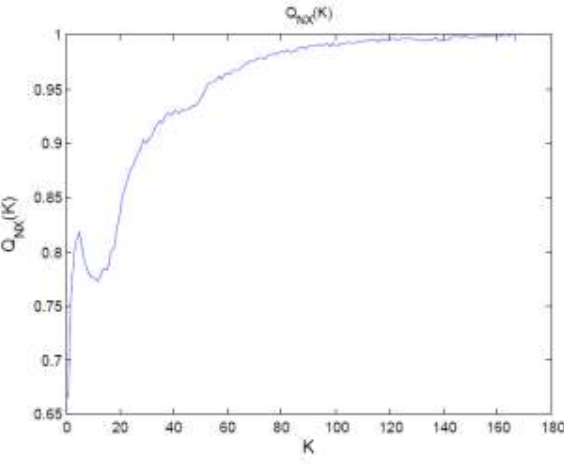
Figure 1. Plot of Q NX (K) versus K for autoencoder